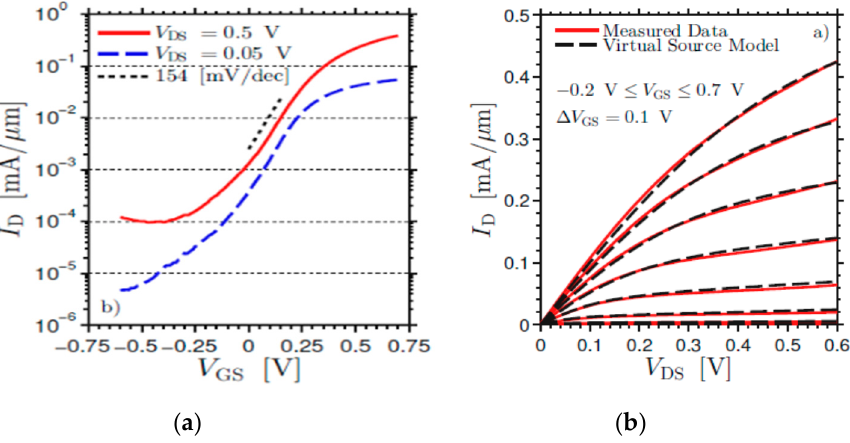
Figure 5. For an InAs vGAAFET consisting of 280 nanowires in parallel with a diameter of 28 nm and gate length of 190 nm: ( a ) Transfer characteristics and ( b ) output characteristics [41].